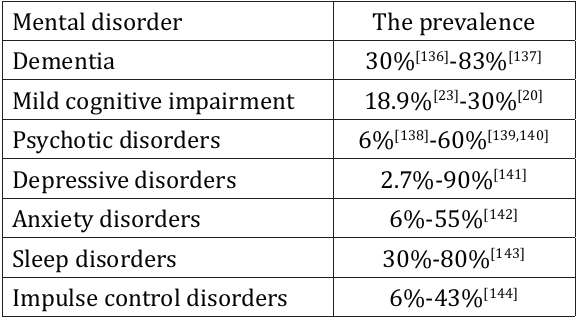
Tab.1 The prevalence of mental disorders among people with